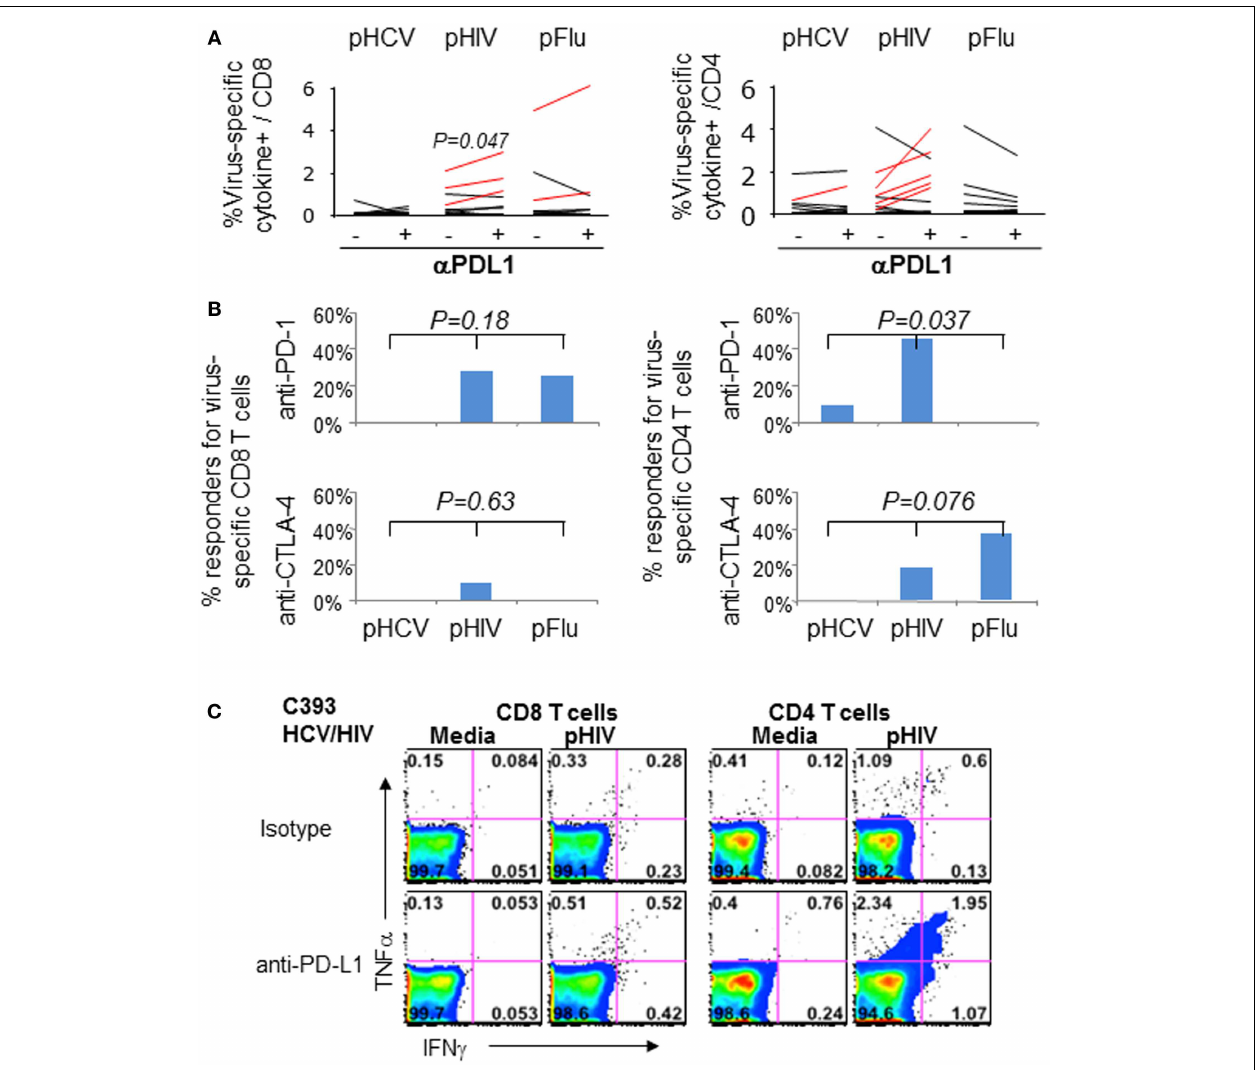
HCV/HIV-coinfected patients, comparing responses with isotype antibody and with anti-PDL1 blocking Ab (10 µ g/ml). Significant P -value per paired t -test is shown for HIV Gag. Assay pairs with augmented responses to PD-1 blockade above isotype control condition are highlighted as red lines. Significant increase in cytokine response by PD-1 blockade is shown for HIV-specific CD8 T cells ( P = 0.047) via paired t -test. (B) Percentage of positive responders (augmentations above 0.36%) to anti-PDL1 or anti-CTLA-4 is shown for virus-specific CD8 (left panel) and CD4T cells (right panel) from HCV/HIV-coinfected patients. Significant anti-PDL1-mediated augmentation is shown for HIV-specific CD4T cell response by Kruskal–Wallis ( P = 0.037). (C) Representative FACS plots are shown for HIV Gag-specific IFN- γ andTNF- α production in CD8 (left) and CD4T cells (right) in short term PBMC culture from HCV/HIV-coinfected patients, following 7day culture with HIV peptides in the presence of either isotype antibody or anti-PDL1. Marked induction in IFN γ andTNF α responses is apparent for CD4T cells following PD-1